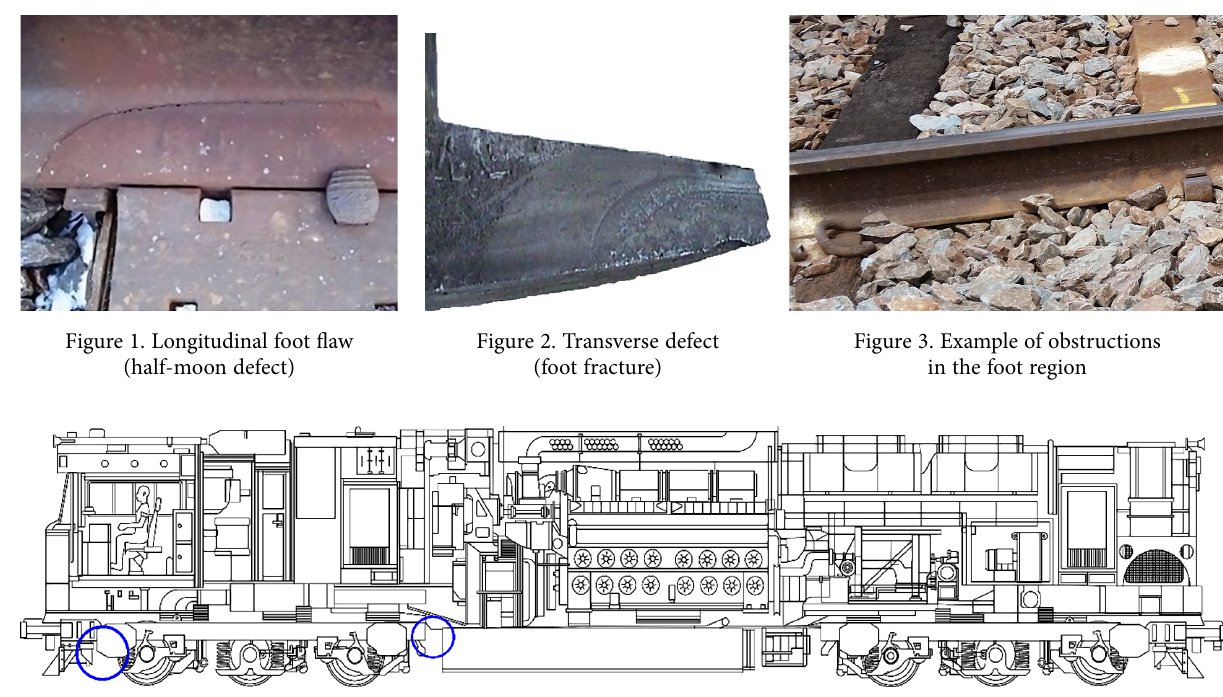
Figure 4. Proposed areas (blue circles) for installation of infrared camera for a thermography base detection